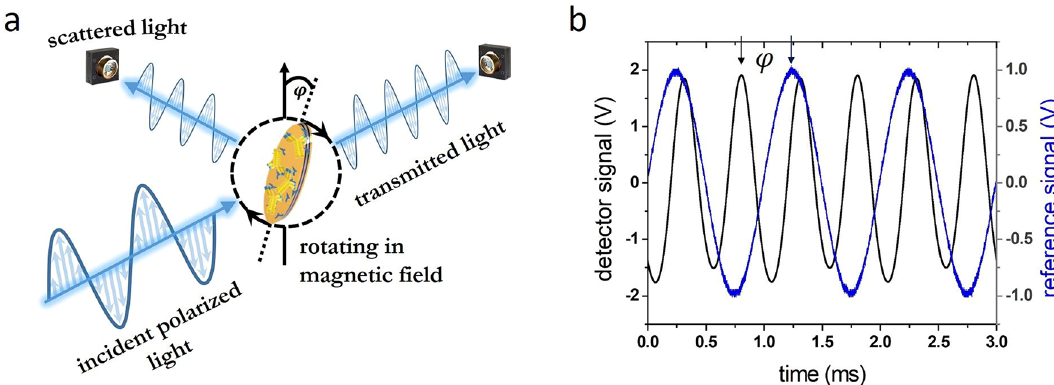
Figure 1. ( a ) Schematic illustration of the detection principle: The functionalized nanoparticle follows a rotating magnetic field, but its orientation lags behind by an angle φ. This angle increases with the number of bound molecules. Consequently, the measured phase lag is proportional to the target molecule concentration in the sample solution. ( b ) Frequency-doubled detector signal (black) and reference coil signal (blue) with phase lag